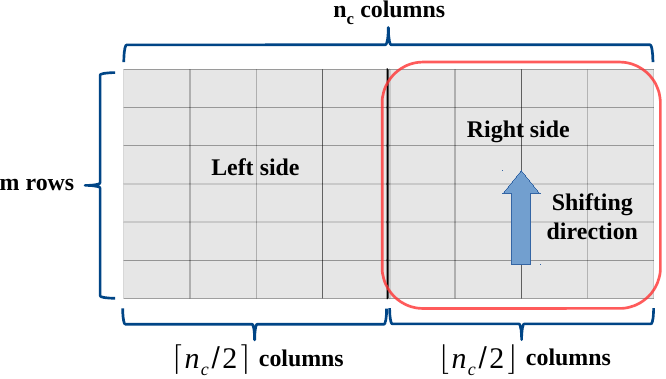
Figure 3. WDT for a generic normal system winding. The right side of WDT is shifted upwards by ζ steps.